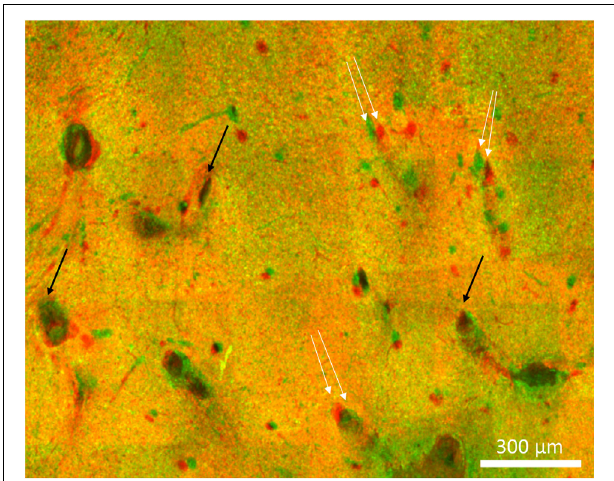
FIGURE 10 | Imperfect alignment of two sections. Black arrows indicate well-aligned fiducials whereas white arrows indicate fiducials that could not be aligned presumably due to distortions in the tissue. The magnitude of the misalignments indicated are 30, 42, and 38 µ m.